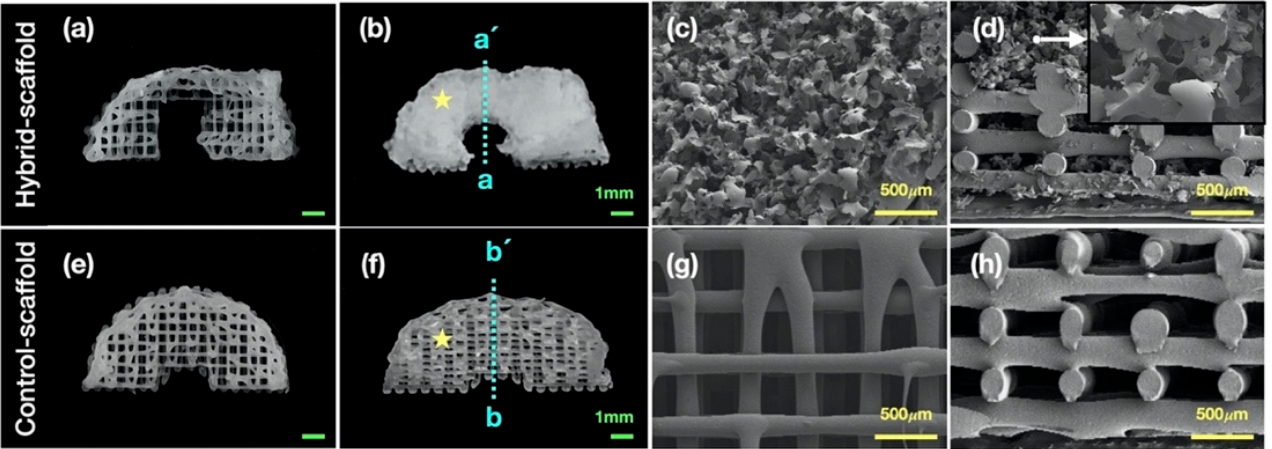
Figure 2. Morphology analysis, optical image of ( a ) 3D-printed PCL framework and ( b ) hybrid-scaffold, FE -SEM image of ( c ) top view (yellow star in b) and ( d ) cross-section view (a-a’). optical image of ( e ), ( f ) 3D-printed PCL framework of the control-scaffold, FE -SEM image of ( g ) top view (yellow star in f) and ( h ) cross-section view (b-b’).